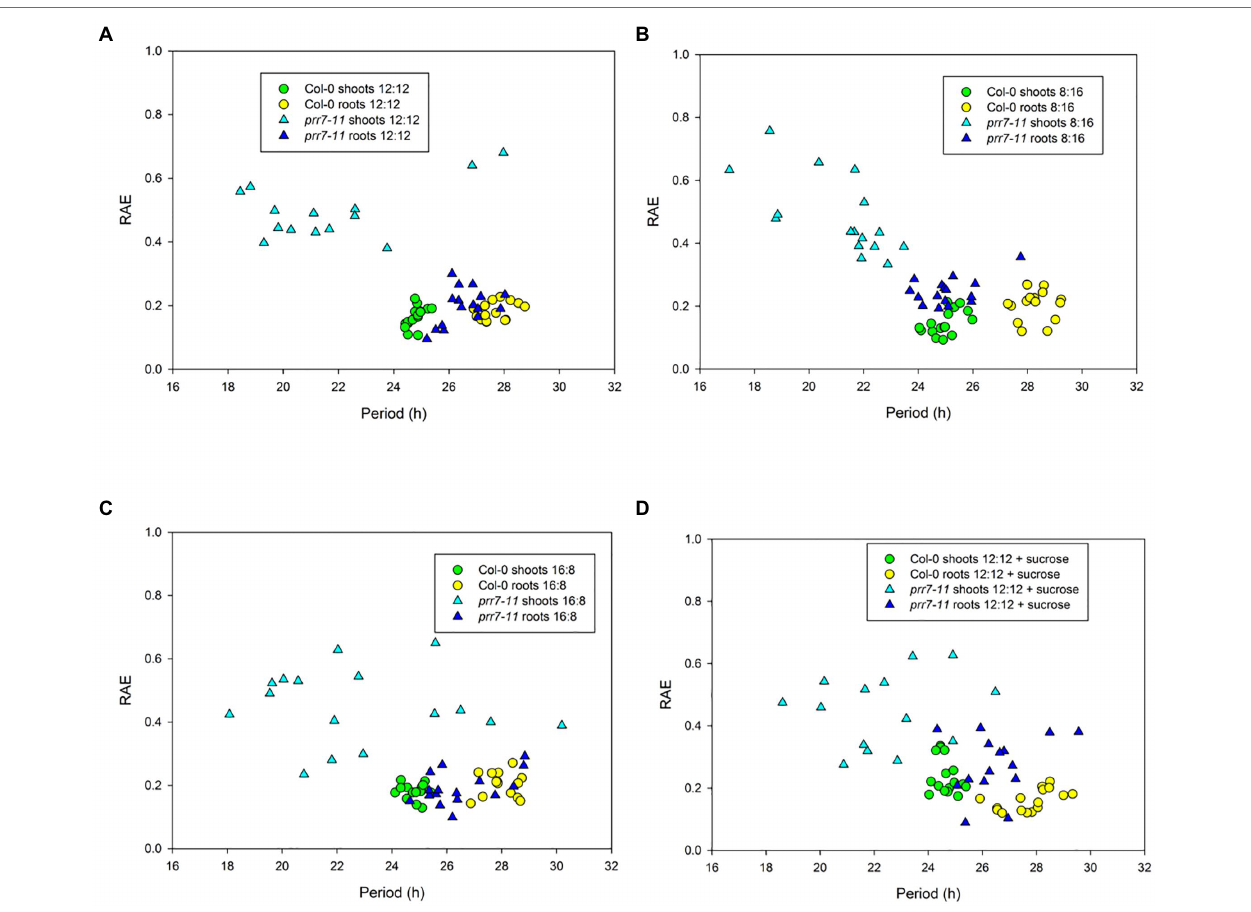
FIGURE 2 | Period and robustness of rhythms in Col-0 and prr7-11 . Period and RAE data for Col-0 (circles) and prr7-11 (triangles) are from individual traces in the experiment shown in Figure 1 . Photoperiods: (A,D) – 12:12; (B) – 8:16; and (C) – 16:8. Plates in (D) contained 1% sucrose.